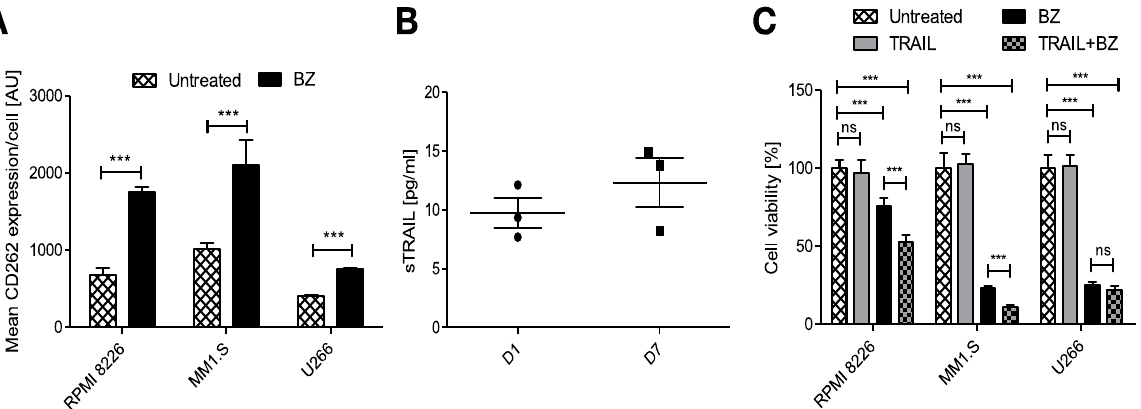
Figure 4. Potential combinatorial therapy against MM with engineered FINM for the expression of TRAIL with BZ. ( A ) Mean CD262 expression per cell (MFI) in RPMI 8226, MM1.S and U266 cells in culture with/without BZ. ( B ) Expression of soluble TRAIL protein by engineered WJ-MSCs within FINM. ( C ) MM cell lines viability with combinatorial and single-agent treatment. Data in ( A – C ) are presented as means ± SD from three technical replicates. ns—not significant; *** − p < 0.001; one-way ANOVA, repeated measures test and Student’s t -test.